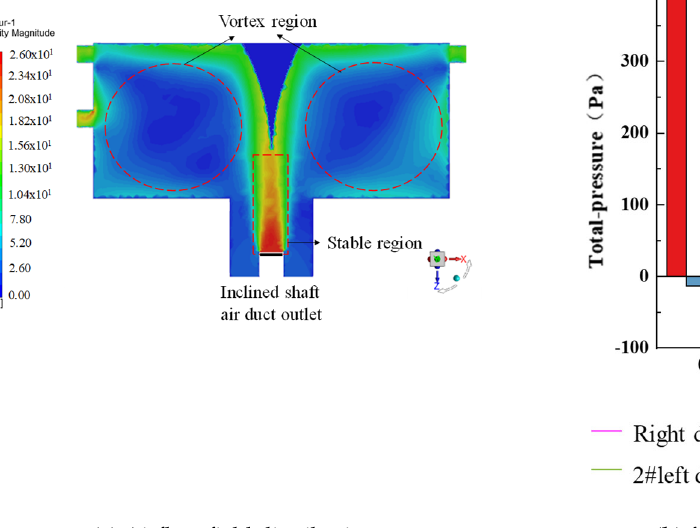
Figure 16. Local resistance in different angles of the middle diaphragm. 4.5. Effect Evaluation of Air Cabin Ventilation System Numerical simulations were conducted to study the dust removal effect of the air cabin ventilation system. The model length was set to 300 m, and the continuous diffusion 0°